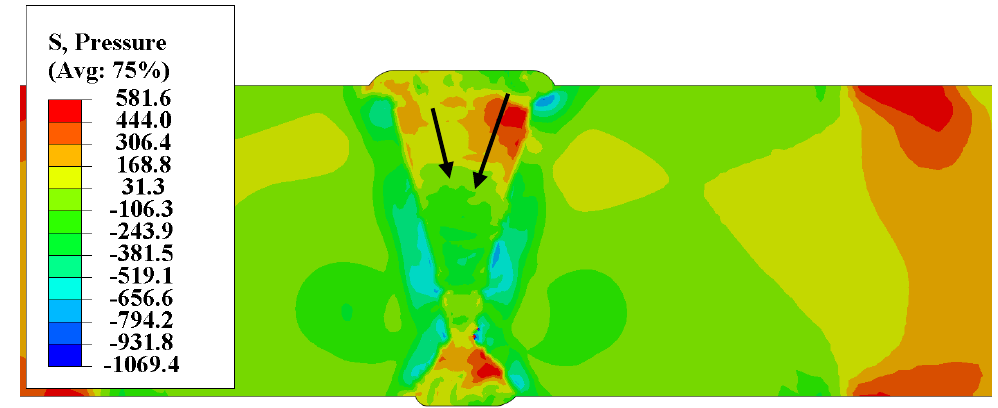
Figure 13. Compressive stress distribution of welded joint of heavy plate.